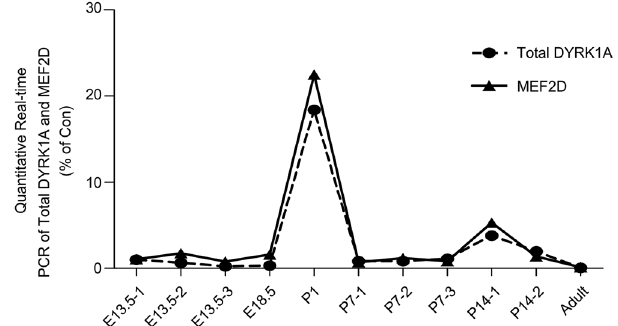
Figure 5. DYRK1A mRNA expression was correlated with MEF2D in mice neurodevelopment. Quantitative real time PCR was performed to detect total DYRK1A and MEF2D mRNA expression. RNA was isolated from normal mouse brain aging at embryonic days 13.5 (E13.5), embryonic days 18.5 (E18.5), postnatal P1, P7, and P14 and adult. One to three mice were used in each time point as indicated by the numbers after the hyphens. p = 0.0478, r = 0.6182 by Spearman correlation test.